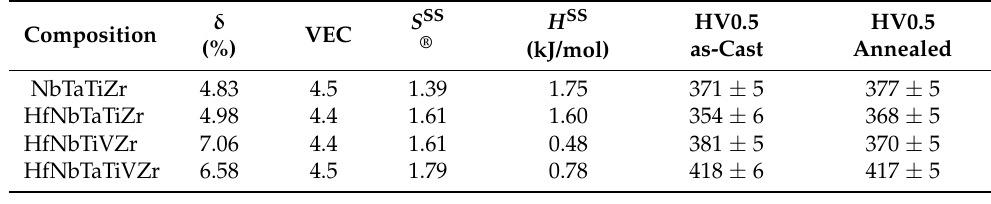
Table 1. A list of compositions and properties of CCAs studied: δ —atomic misfit parameter; VEC— average valence electron concentration; S SS —molar configurational entropy of ideal solid solution in units of the universal gas constant R ; H SS —mixing enthalpy of solid solution; HV0.5—Vickers hardness of the alloy in the as-cast state and after annealing in vacuum at 1200 ◦ C for 2 h finished by quenching.